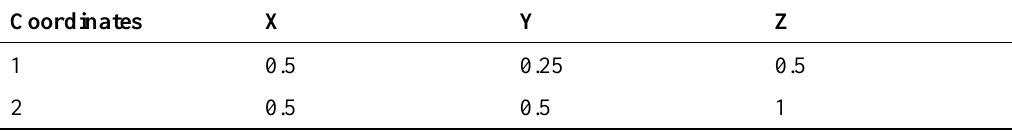
Table 1. Trajectory input values